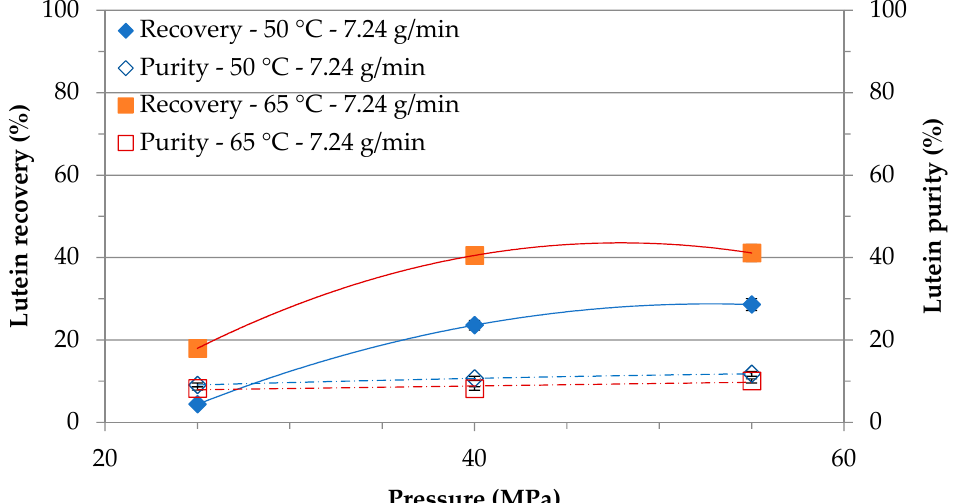
Figure 2. Influence of SF-CO 2 extraction temperature and pressure at CO 2 flow rate of 7.24 g/min on the recovery and purity of lutein.